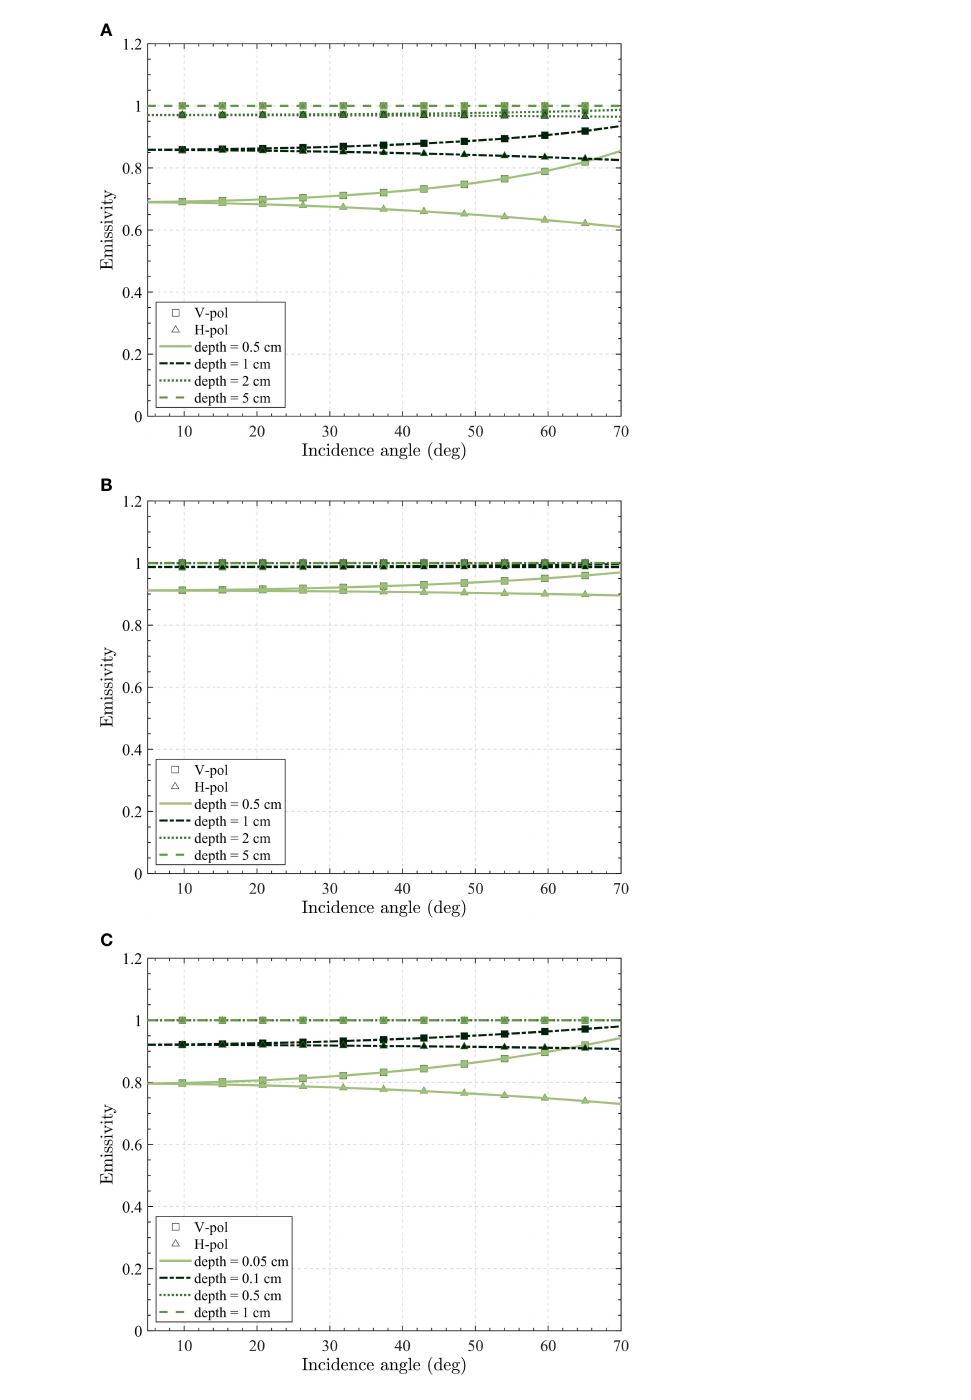
FIGURE 3 Dependence of foam emissivity on incidence angle at three frequencies: (A) 1.4 GHz; (B) 18.7 GHz; (C) 37 GHz with four different foam layer thicknesses. V-pol (triangle symbols) and H-pol (square